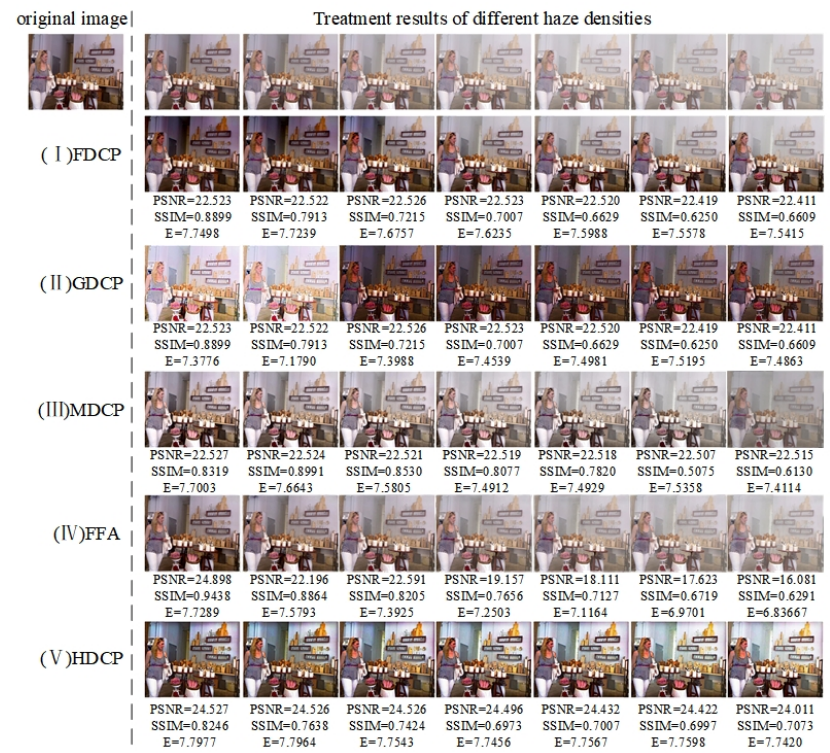
Figure 5. Each algorithm’s results for different haze densities comparison groups. The processing results are, respectively, from: ( Ⅰ ): FDCP [26], ( Ⅱ ) : GDCP [27], ( Ⅲ ): MDCP [15], ( Ⅳ ): FFA [19], and ( Ⅴ ): HDCP.